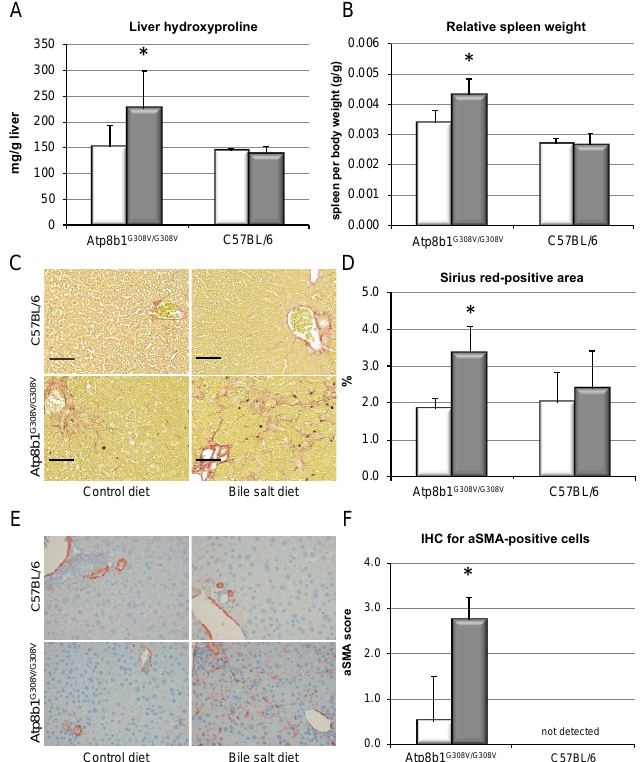
Figure 3. Chronic cholestasis in Atp8b1 G308V/G308V mice induces liver fibrosis in the presence of GCDCA. Atp8b1 G308V/G308V and wild-type mice (C57BL/6) were fed a standard diet (white bars) or a CA (0.1%